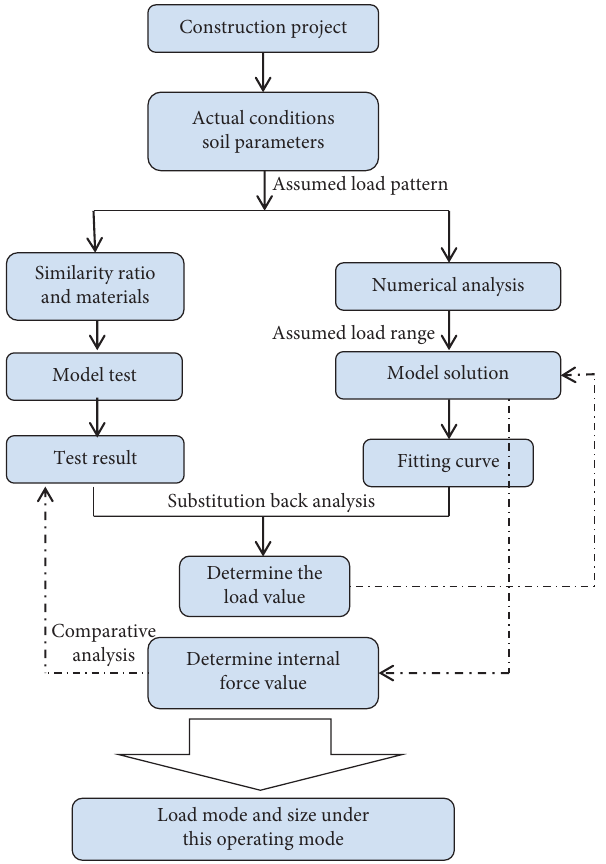
Figure 1: Outline of the research route followed in this